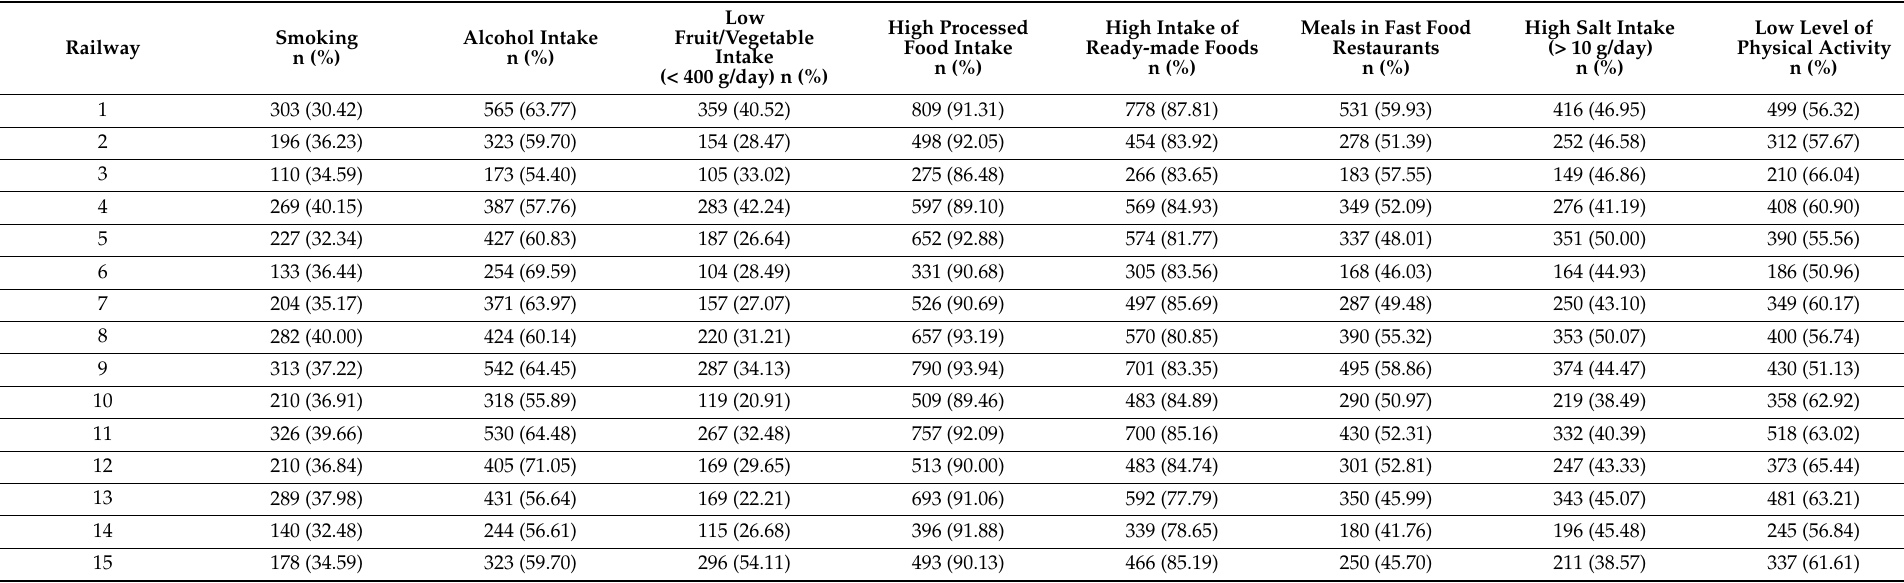
Table 2. Self-reported behavior risk factors for crew members by